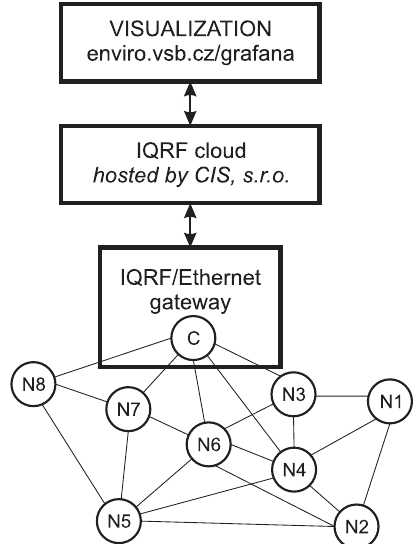
Figure 6. Block scheme for monitoring the environmental quantities at the Department of Cybernetics and Biomedical Engineering at VŠB-TUO.